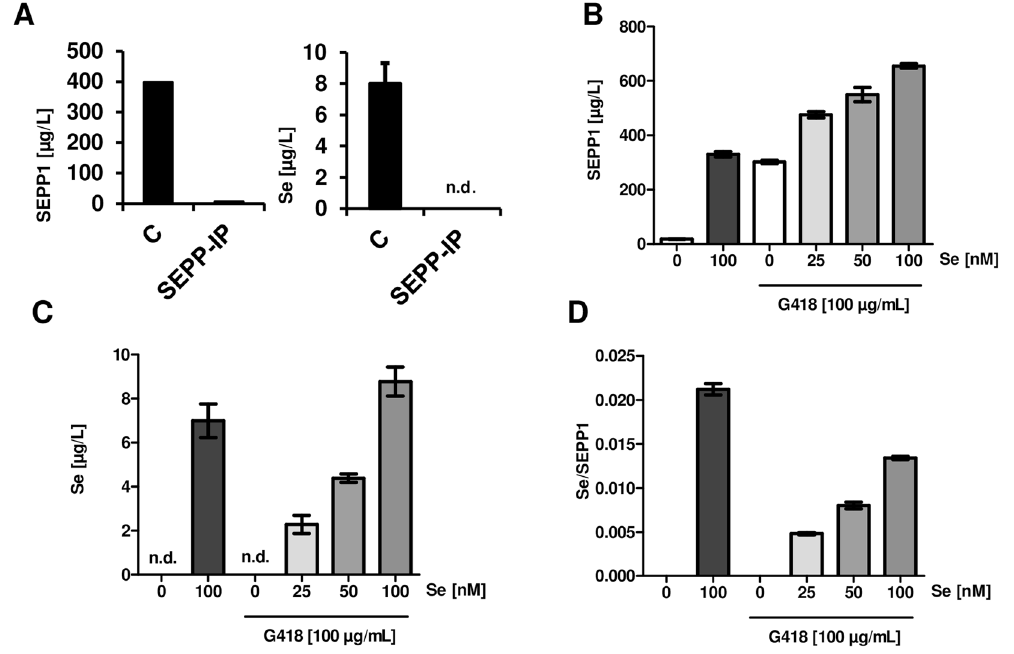
Figure 4. Se-content of SELENOP in relation to G418 and supplemental selenite. ( A ) The protein fraction of conditioned media from HepG2 cells was immobilized on a nitrocellulose membrane before and after immuno- precipitation of SELENOP (SEPP -IP). The SELENOP-IP procedure efficiently removed SELENOP (SEPP1), and with it all the detectable Se from the culture medium. ( B ) Supplemental selenite and G418 increased immuno-detectable SELENOP (SEPP1). ( C ) Se content of SELENOP preparations varied strongly between the different incubation conditions. ( D ) A comparison of the Se/SELENOP (Se/SEPP1) ratio indicates that G418 induces Sec-free SELENOP variants, whereas selenite increased the Se content of SELENOP in the presence of G418. (Mean ± SEM, n = 3).